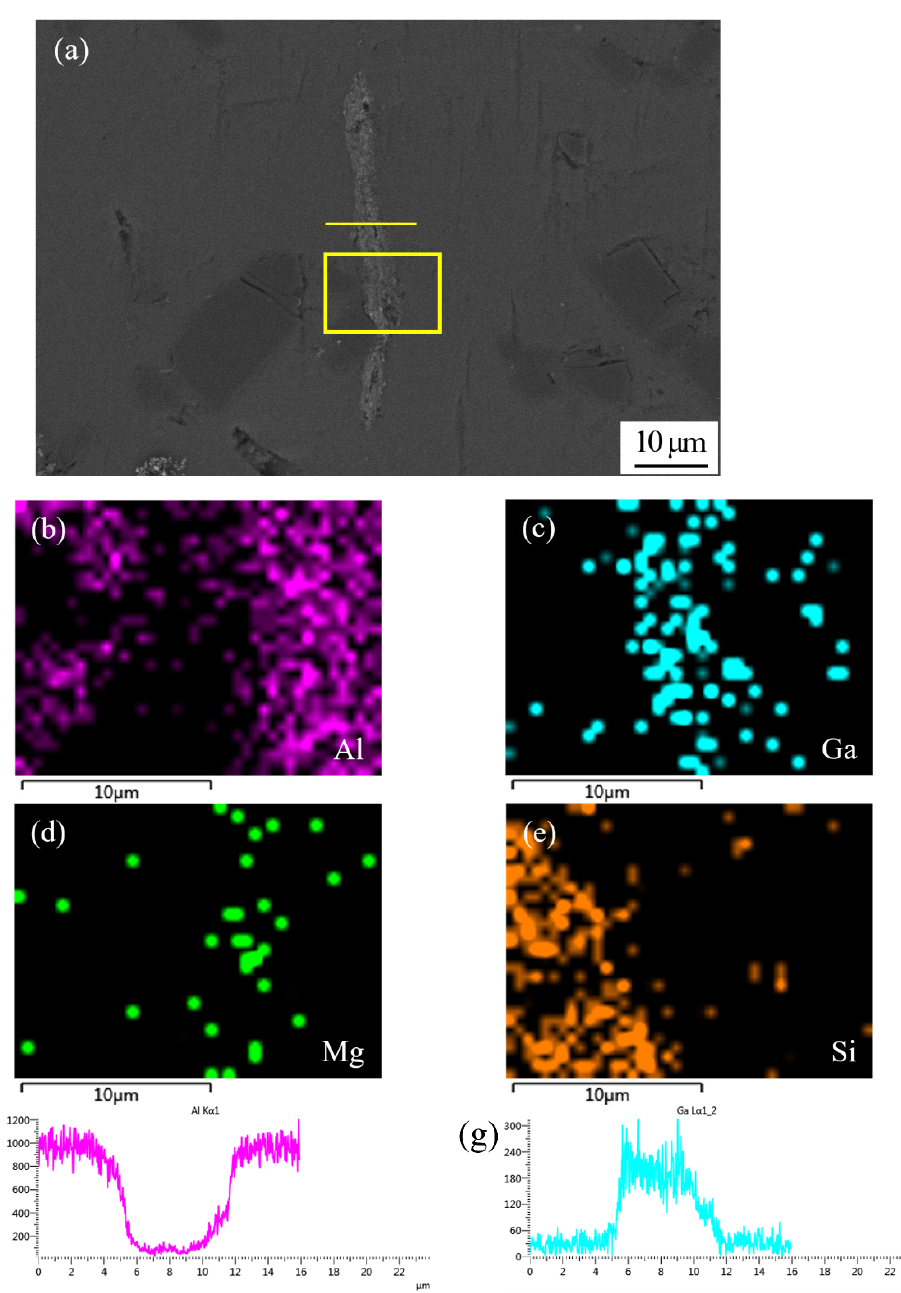
Figure 8. SEM micrograph at the interface of SiC p /6063 Al MMCs joint bonded at 450 °C using liquid Ga, and the corresponding energy dispersive X-ray maps showing distribution of elements: ( a ) SEM image; ( b – e ) individual elemental mapping of Al, Ga, Mg and Si, respectively; ( f – g ) line scanning profile of elements Al and